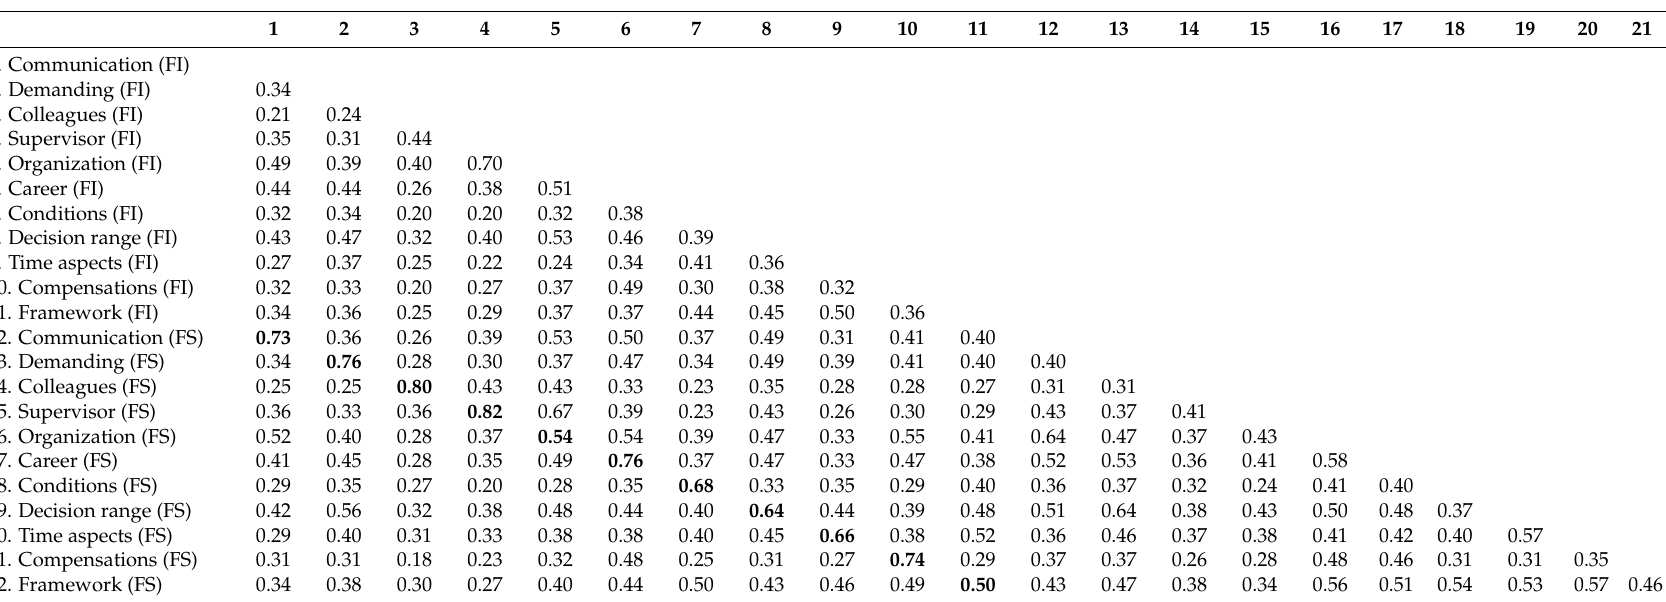
Table 3. Correlations between Profile Analysis of Job Satisfaction (PAJS, facet scales) and PAJS-Facet-Item (PAJS-FI, facet-items, N = 788) 1